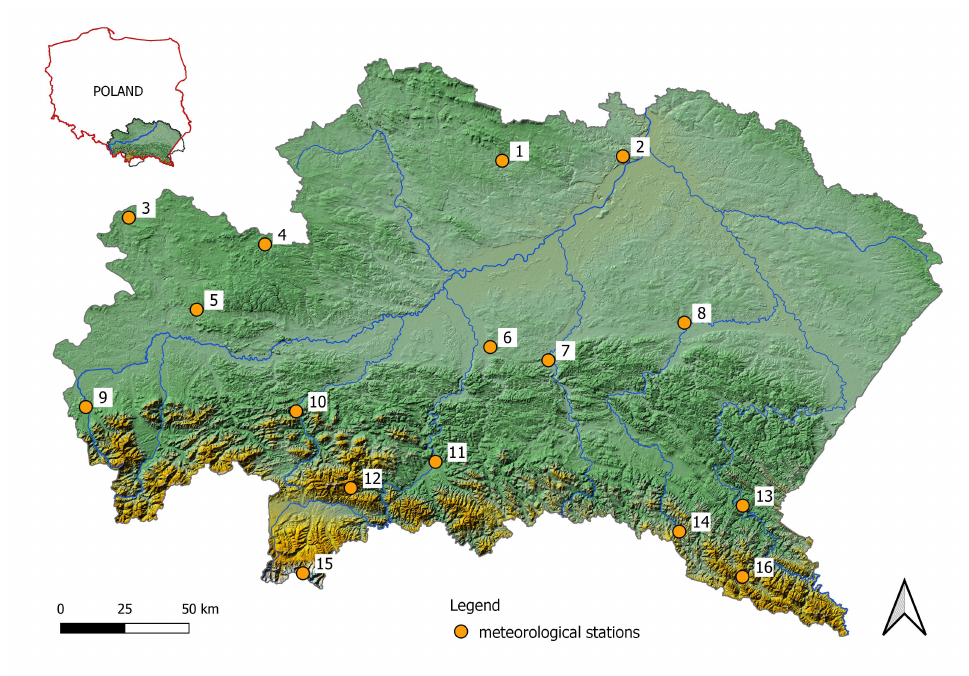
Figure 1. The location of the stations used in the study. 1. Raków, 2. Sandomierz, 3.